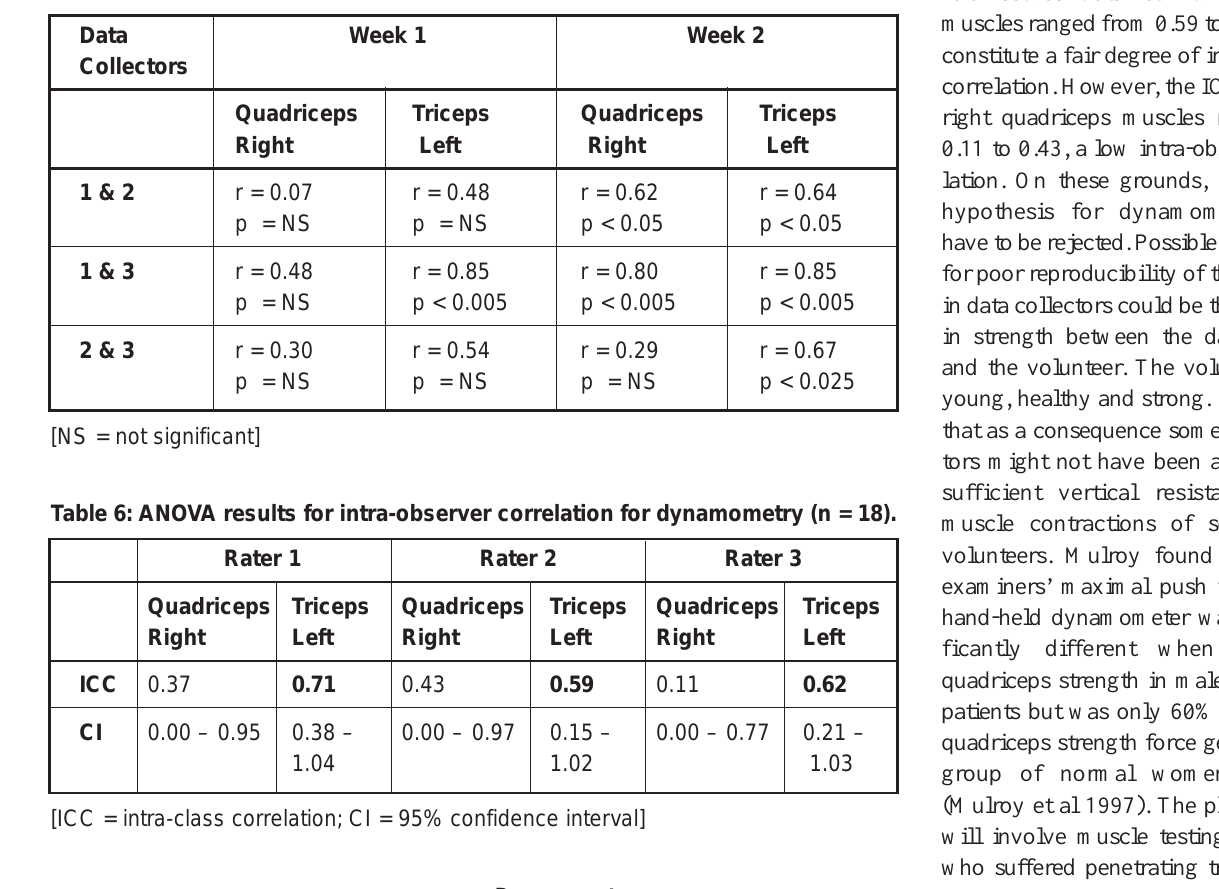
Table 5: Pearson product moment correlation coefficient results for dyna- mometry (df = 7).